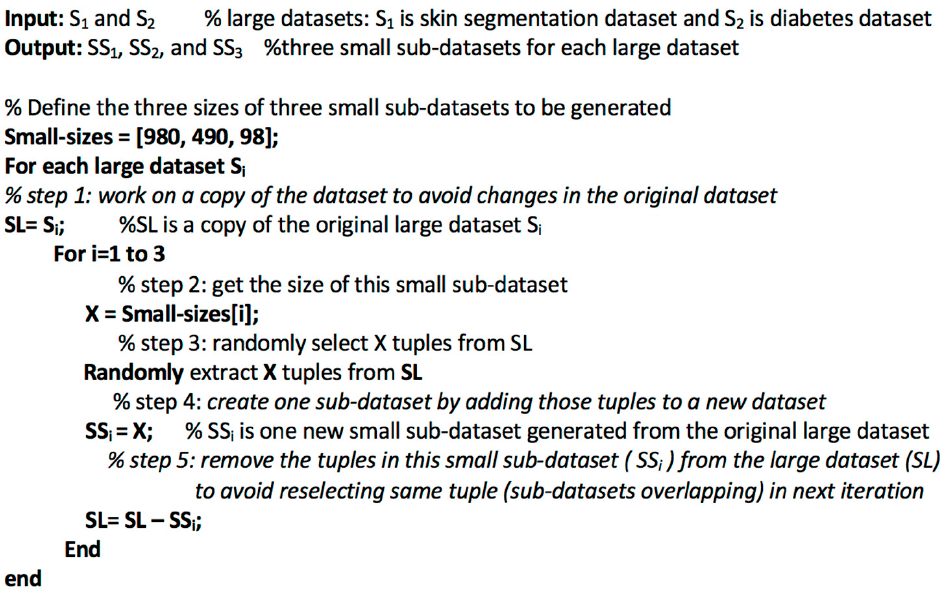
Figure 1. Dataset partitioning algorithm.